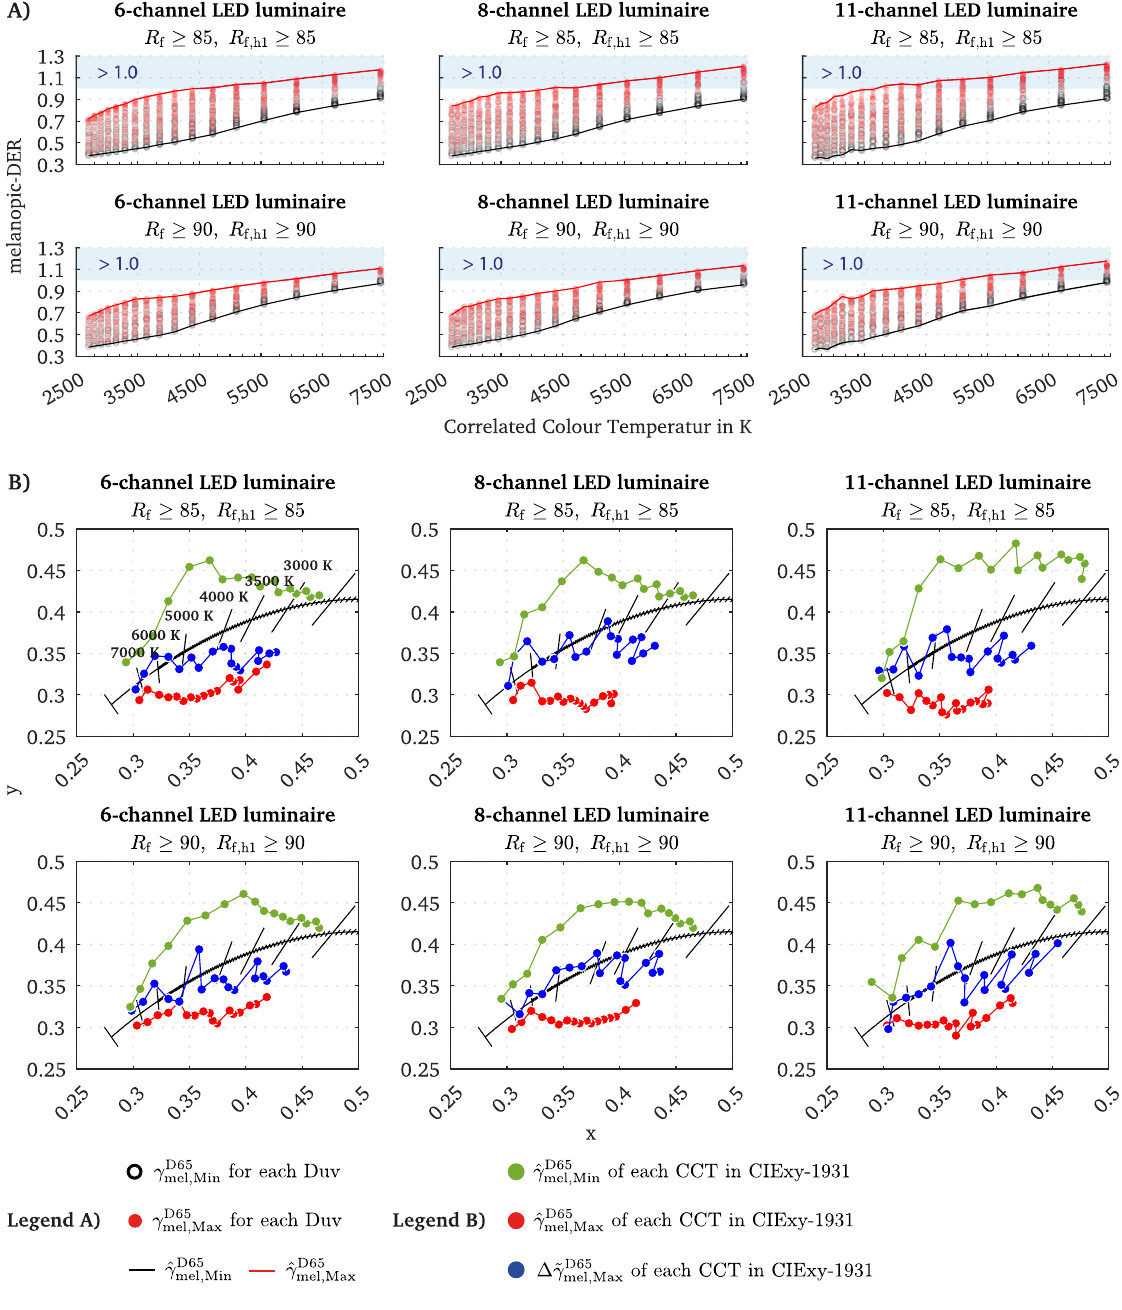
Figure 4. The melanopic DER as a function of CCT and the ideal chromaticity coordinates to reach spectra D 65 D 65 with the highest or lowest circadian efficacy. ( A ) Scatter plot of the γ mel , Min and γ mel , Max values as a function of the CCT. As for each CCT value several Duv distances to Planck were used as optimisation targets multiple D 65 D 65 solutions are available. The black lines indicate (cid:31) γ mel , Min value for a particular CCT mel , Min , which is the lowest γ D 65 D 65 across all Duv steps. The red line refers to (cid:31) γ mel , Max value for each CCT across all mel , Max , which is the largest γ Duv steps. ( B ) Identified ideal chromaticity coordinates for optimisation pipelines to get the spectra with the D 65 (cid:31) γ D 65 largest melanopic efficacy ( (cid:31) γ mel , Max , red line in ( A and B ), lowest melanopic efficacy ( mel , Max , black line in ( A ), D 65 green line in ( B ) or the largest melanopic tuning range (blue line in B ) with � (cid:31) γ mel through metamer